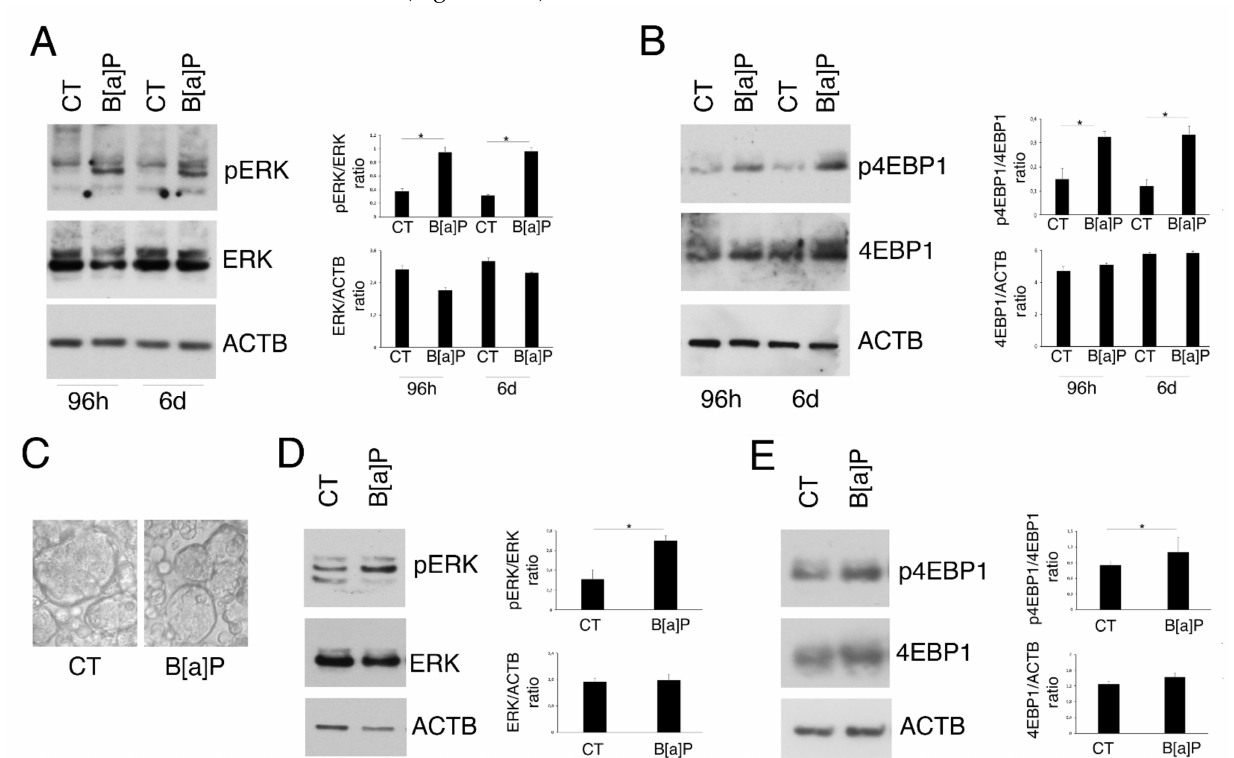
Figure 2. ERK and mTOR pathways are activated by B[a]P in HCoEpC cultured in 2D and 3D. ( A ) Phospho-ERK 1/2 (pERK) and ( B ) phospho-4EBP1 (p4EBP1) levels were evaluated in HCoEpC